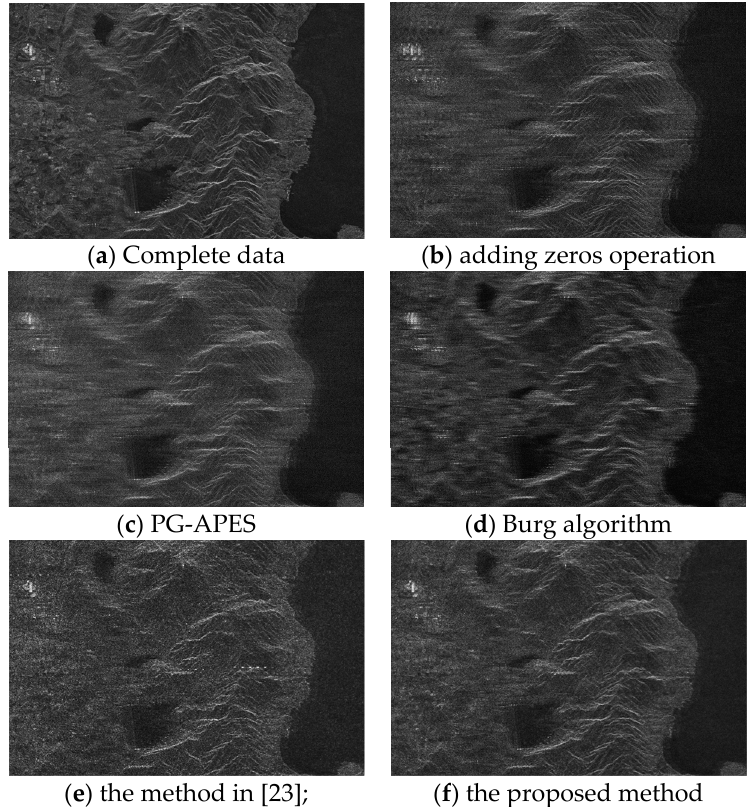
Figure 24. Results of Region 2: ( a ) complete data; ( b ) adding zeros operation; ( c ) PG-APES; ( d ) Burg algorithm; ( e ) the method in [23]; and ( f ) the proposed method.